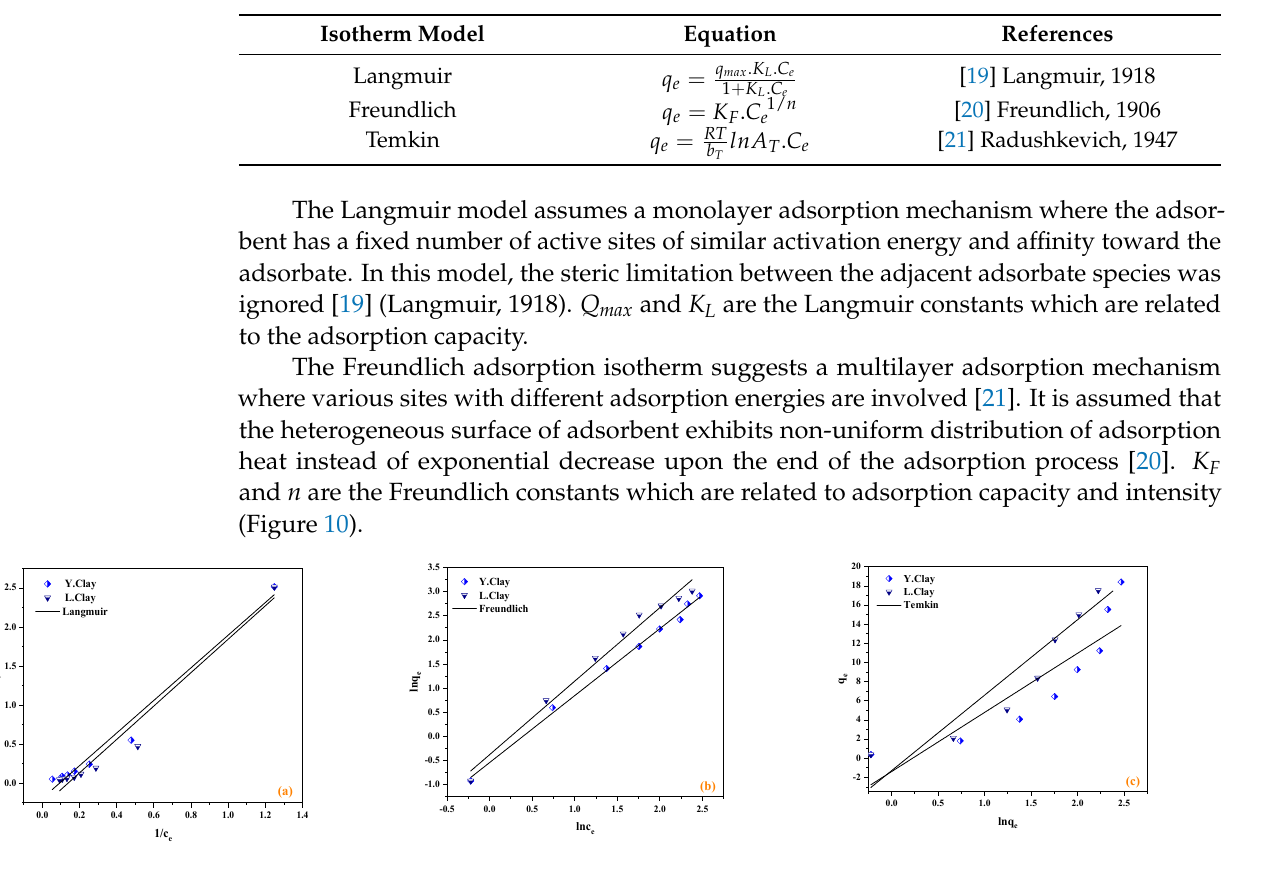
Figure 10. ( a ) Langmuir, ( b ) Freundlich, ( c ) Temkin Figure 10. ( a )Langmuir, ( b ) Freundlich, ( c ) Temkin isotherms. The Temkin isotherm contains a factor that explicitly considers the adsorbent–ad- sorbate interactions. The model assumes that the heat of adsorption of all molecules in the layer would decrease linearly rather than being logarithmic with coverage [22]. b T is the constant of adsorption energy, T is the temperature (K), and A T the binding constant at equilibrium (L·g − 1 ). The parameters obtained from the three models are summarized in Table 5. It was regarded that the adsorption data fitted well with the Freundlich isotherm model (R 2 = 0.99), indicating the heterogeneous surface with non-uniform distribution adsorption heat and affinities. n values lie between 0 and 1 which confirmed the heterogeneous nature of the surface. The kf constant values were in the order Y.clay ˃ L.clay, which is not the same order of the adsorption capacity of the samples. According to the Temkin model, the var- iation of adsorption energy was positive, which means adsorption reaction is endothermic and spontaneous. R L is less than 1 indicating the possible and favorable adsorption of crystal violet on clay samples. These results indicated that the adsorption is multilayer on the heterogeneous surface of L.clay and Y.clay in a possibly spontaneous way.